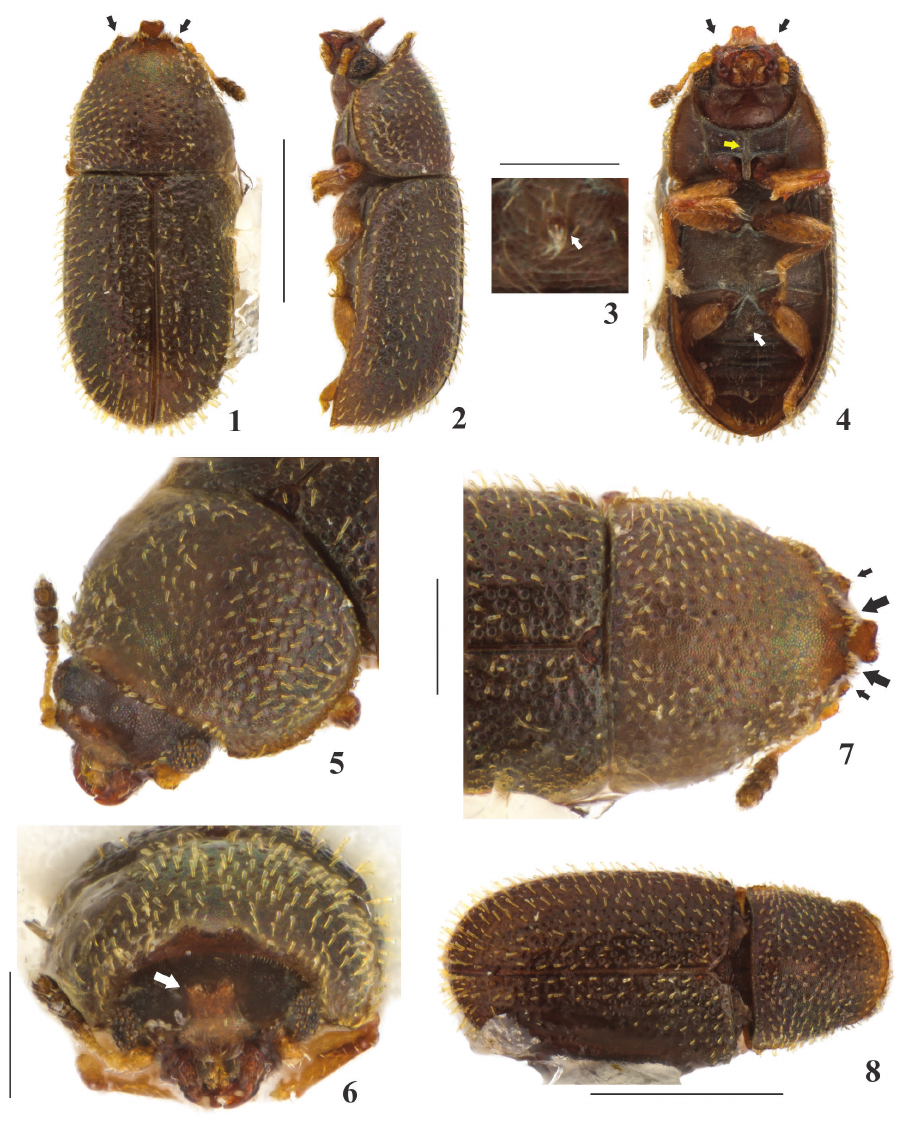
Figures 1–8. Cis mooihoekite sp. n. Male holotype (Figs 1–7 ): 1 Dorsal view, note acute corners of male anterocephalic edge (arrows) 2 Lateral view 3 Part of first abdominal ventrite, showing sex patch (arrow) 4 Ventral view, note prosternal carina (yellow arrow), abdominal sex patch (white arrow) and acute corners of anterocephalic edge (black arrows) 5 Oblique view of head, pronotum and part of anterior portion of elytra with scutellar shield 6 Frontal view of head and pronotum, note frontal lamina of head (arrow) 7 Dorsal view of anterior portion of elytra with scutellar shield, pronotum and part of head; note small triangular horns of pronotal plate (large arrows) and acute corners of anterocephalic edge (small arrows) 8 Female paratype. Scale bars: 0.5 mm ( 1–2, 4, 8 ); 0.1 mm ( 3 ); 0.2 mm ( 5–7